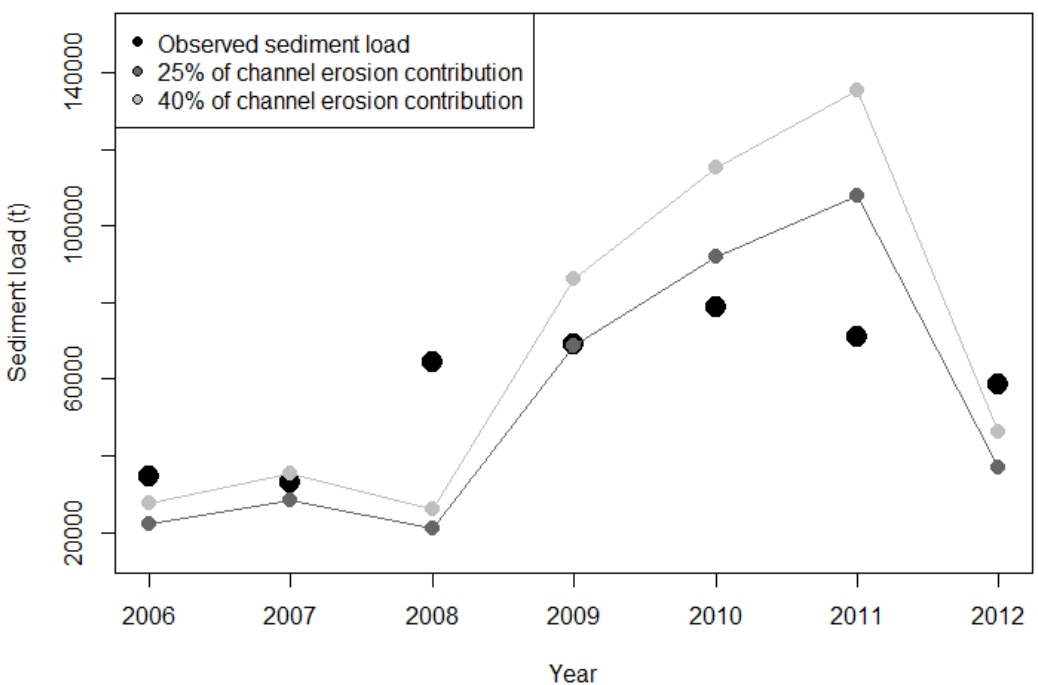
Figure 10. Time series of the relationship between observed and simulated annual sediment load at the LLCW outlet, assuming a channel erosion contribution of 25% and 40% of the total hill-slope sediment production.